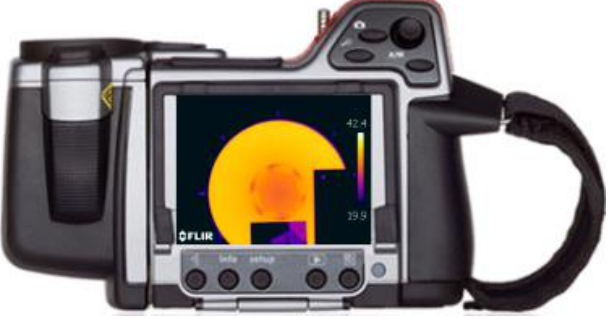
Figure 23. Thermogram taken with the FLIR T425 camera at instant 1565 s.